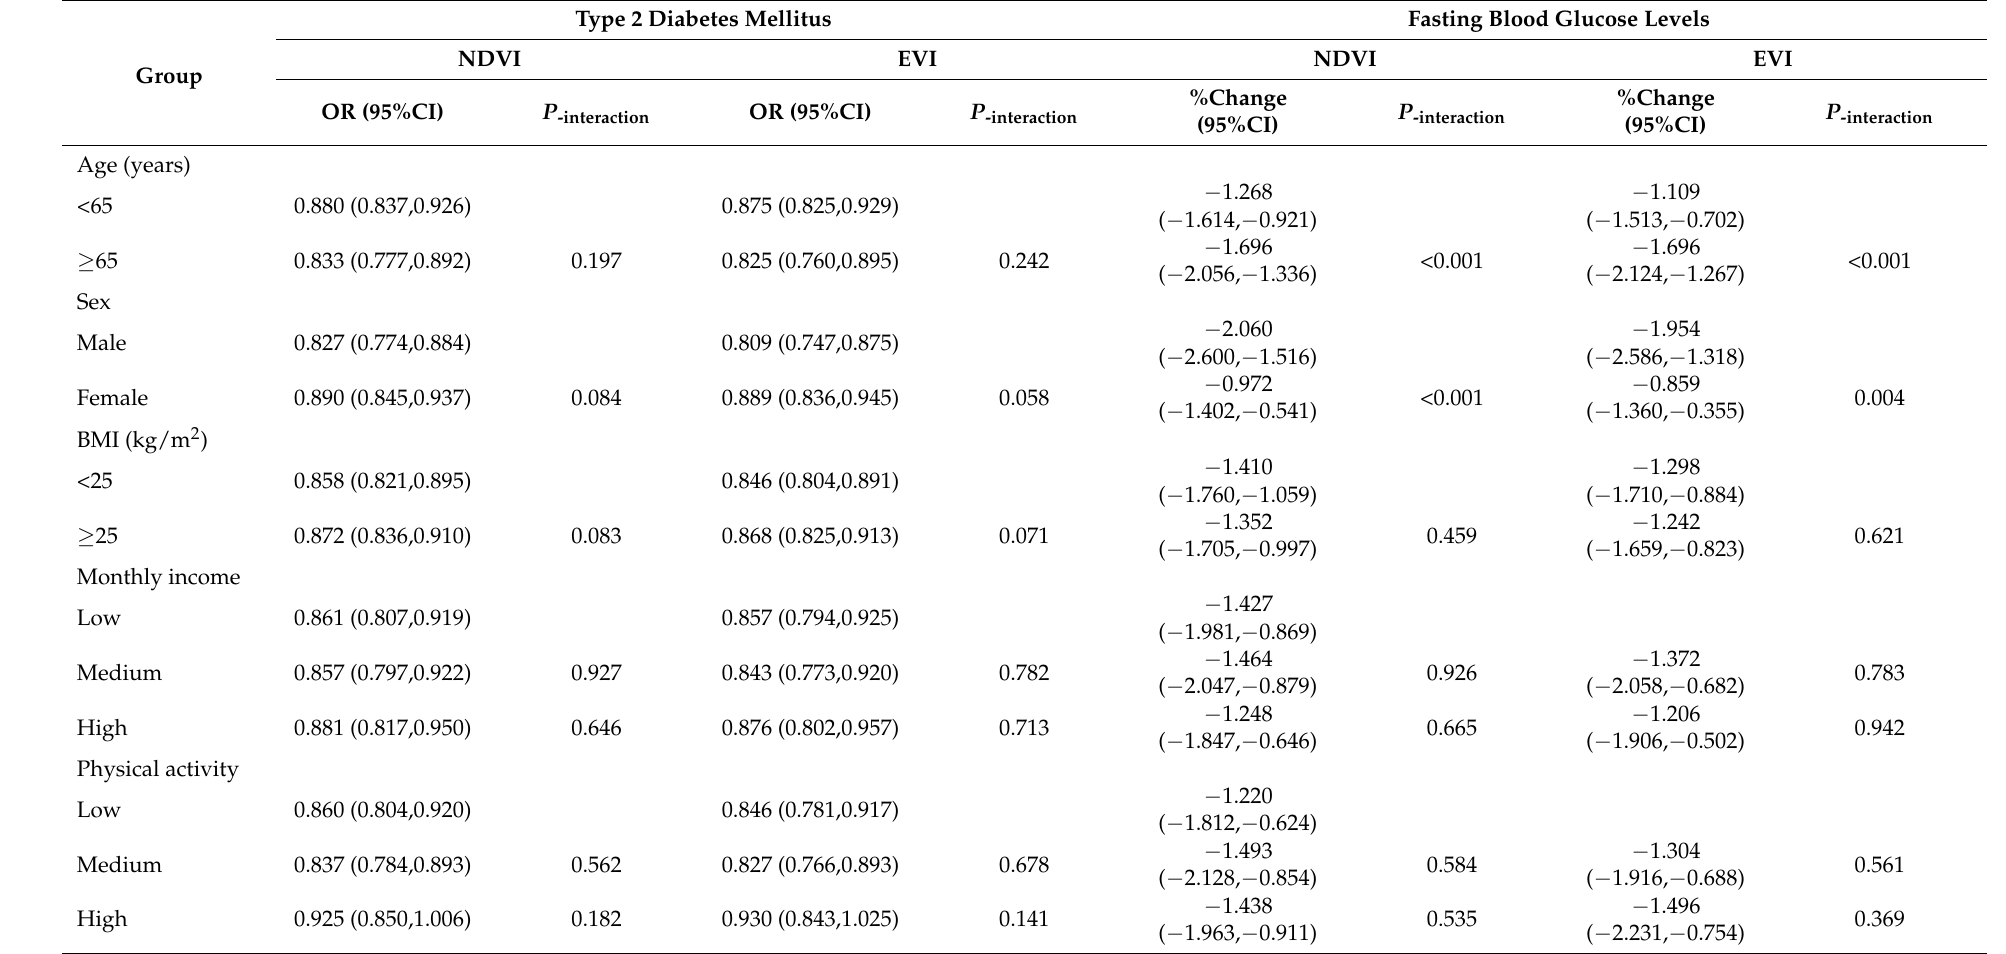
Table 3. Interaction effects of the association between residential green space and type 2 diabetes mellitus and fasting blood glucose levels.